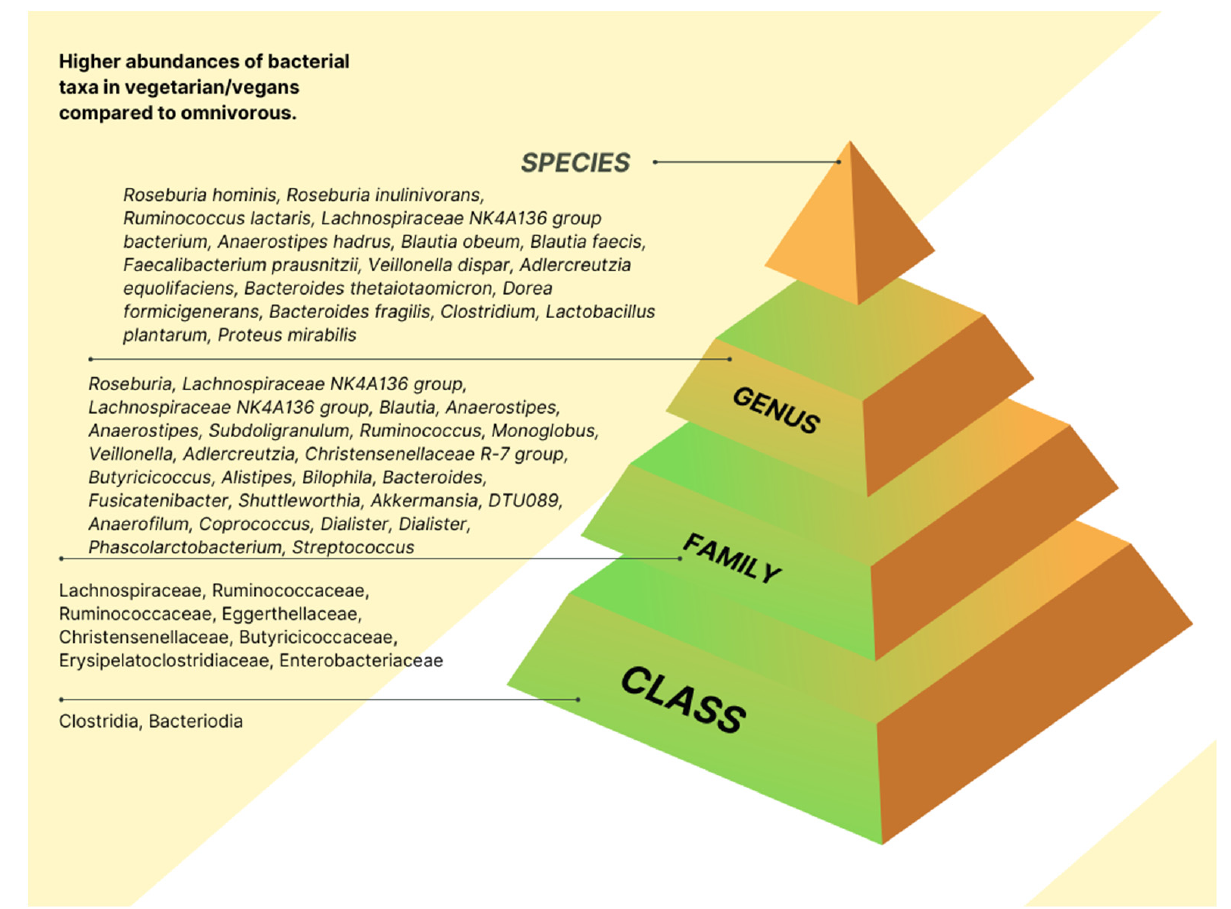
Figure 2. Higher abundances of bacterial taxa in vegetarian/vegan intervention diets. The figure was created and edited from the images available on Canva.com using a Pro Content License.